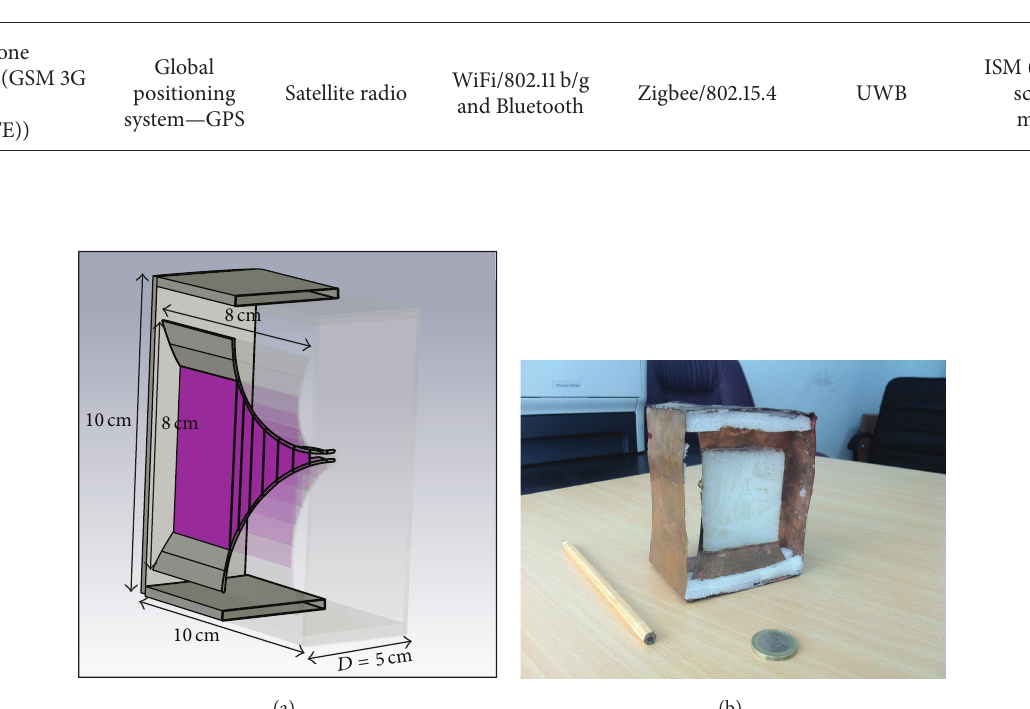
Figure 3: (a) VS-PDL TEM horn antenna design with its dimensions given on the figure. (b) The manufactured antenna.